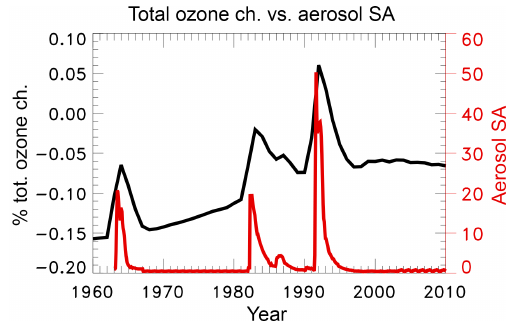
Figure 12. GSFC 2-D model GCR-computed AAGTO im- pacts (black line) over the 1960–2010 time period (simulation C_GCR_GSFC compared to C_Base_GSFC ). The aerosol surface area (SA) at 50hPa and the Equator is also shown (red lines), given in 10 − 8 cm 2 cm − 3